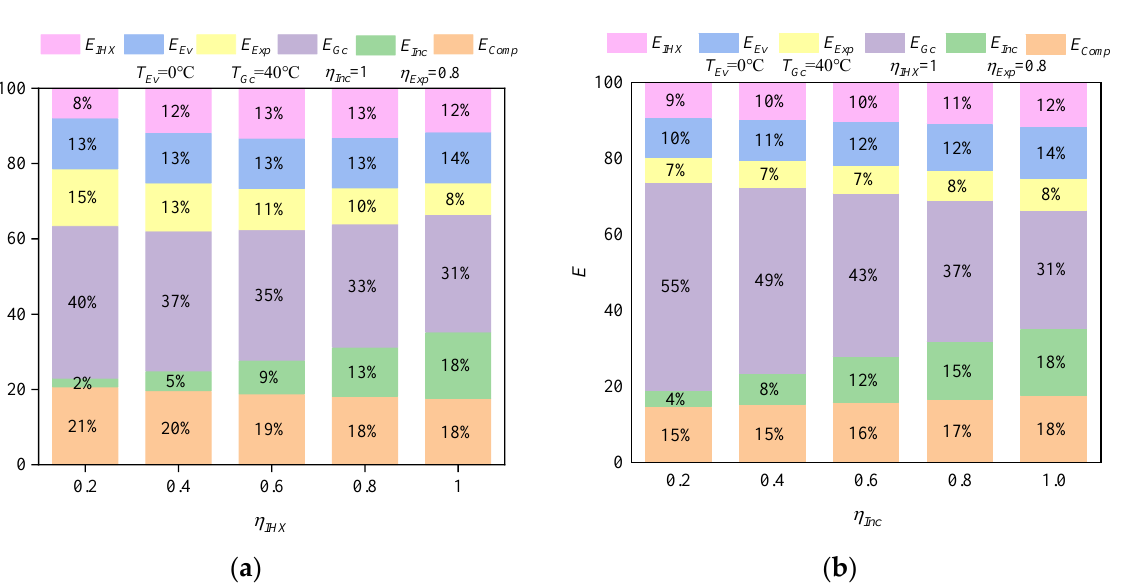
Figure 13. Effect of temperature on the system’s components exergy loss percentage: ( a ) The effect of T e ; ( b ) The effect of T gc .